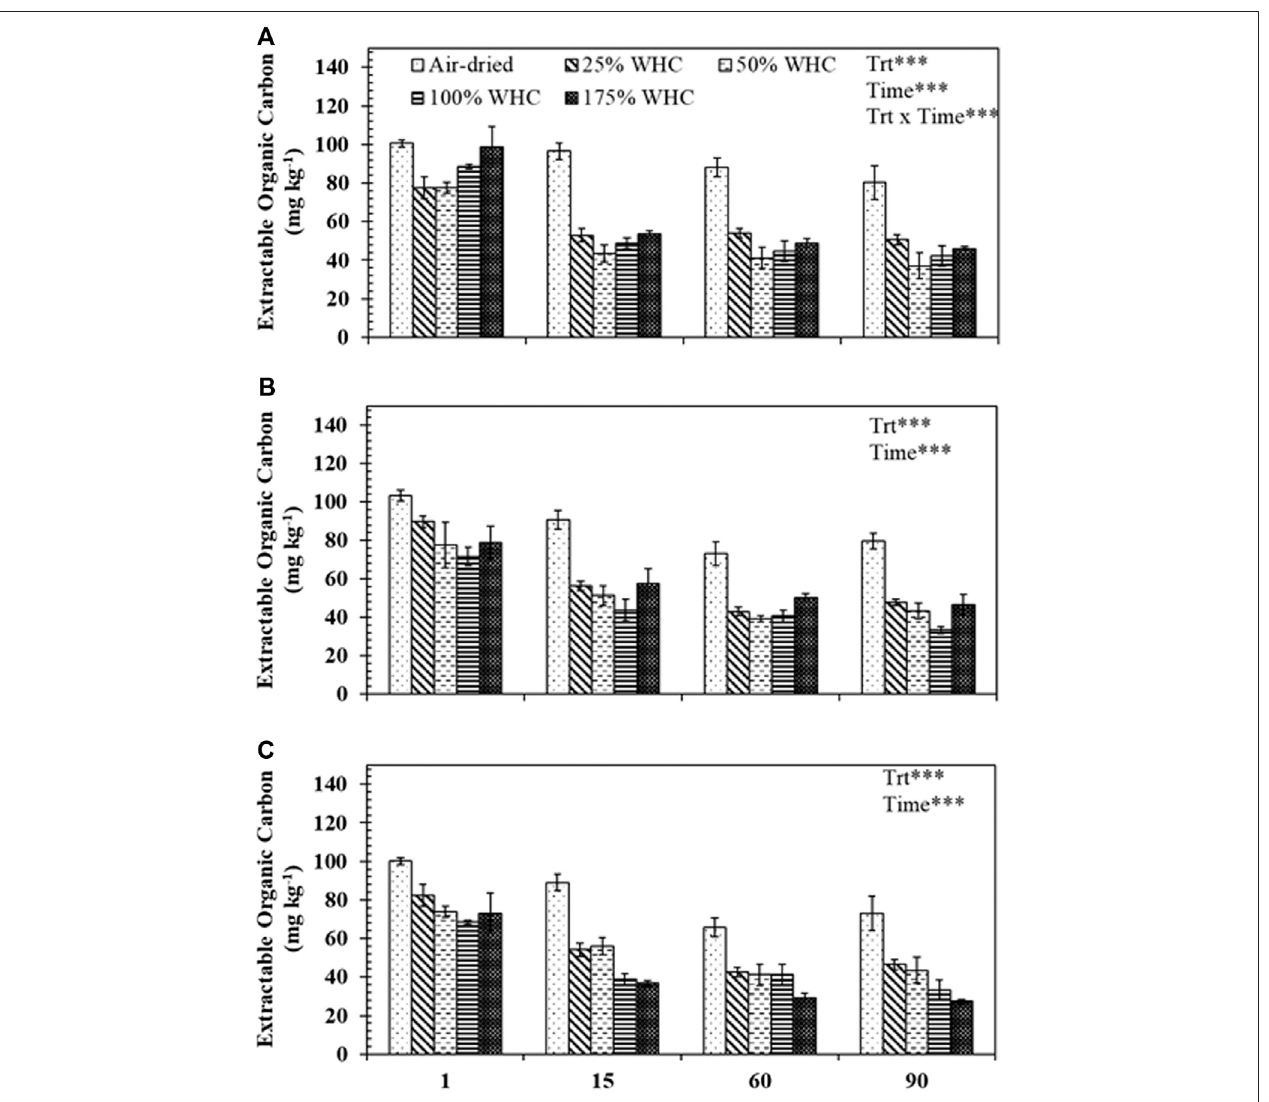
FIGURE 4 | Extractable organic carbon concentrations for different soil moisture treatments in (A) Ultisol, (B) Al fi sol, and (c) Vertisol at each destructive sampling time. Error bars represent the standard errors ( n (cid:1) 3). *** denotes p < 0.001 for the effects of treatment (Trt), time, and treatment and time interaction (Trt x Time).